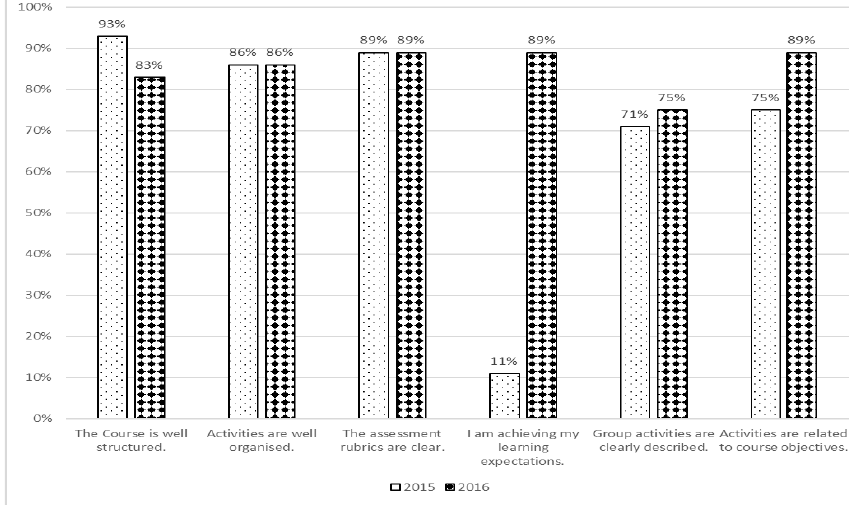
Fig. 2. Do groups reduce